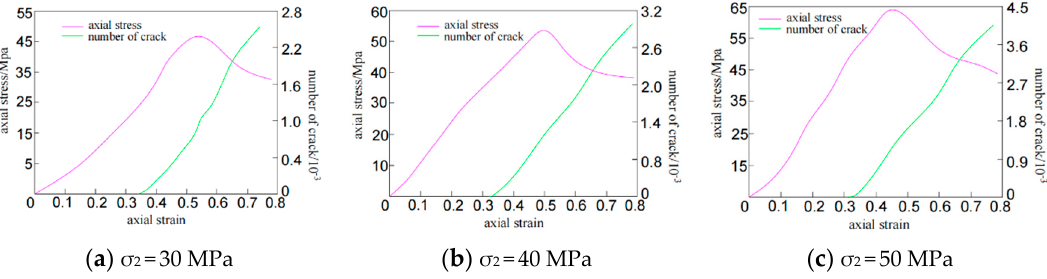
Figure 8. The number of cracks in the specimen under different medium stresses.